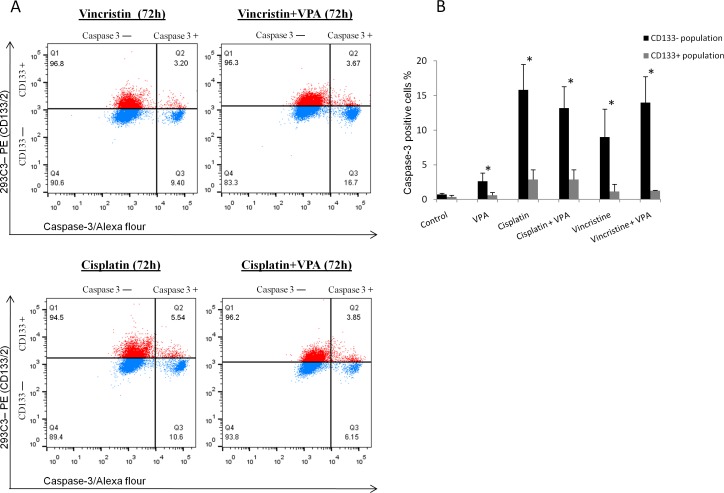
Activated caspase-3 in CD133– and CD133+ populations after treatment with VPA combined therapy for 72 hrs.(A) Activated caspase-3 was higher in CD133− cells compared to CD133+ cells. Blue—isotype control (IgG2b-PE); red—CD133 expression detected by 239C3 (CD133/2) antibodies. (b) Mean cleaved caspase-3 was significantly higher in CD133− than in CD133+ cells in all tested samples.*p < 0.05—paired t-test.